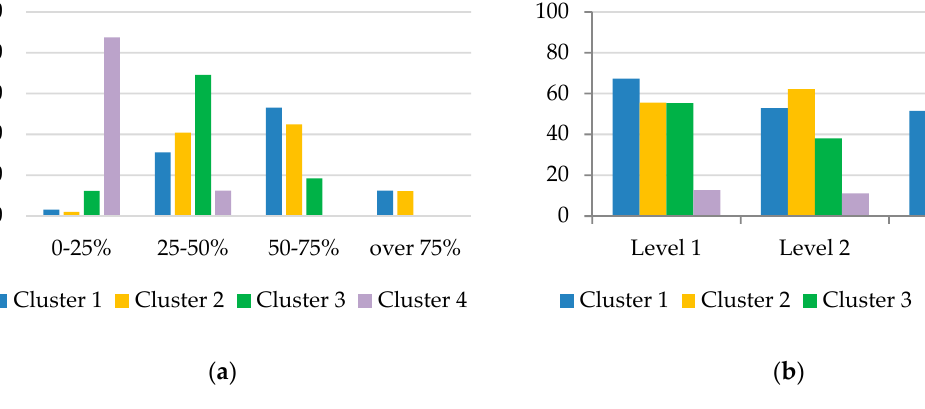
Figure 3. Characteristics of clusters based on the VPi4 index: ( a ) VPi4 index results of enterprises (0 − 25% minimum, over 75% maximum of VPi4 index level) and ( b ) VPi4 index levels 1 − 3 (Factors 1 − 3) results.